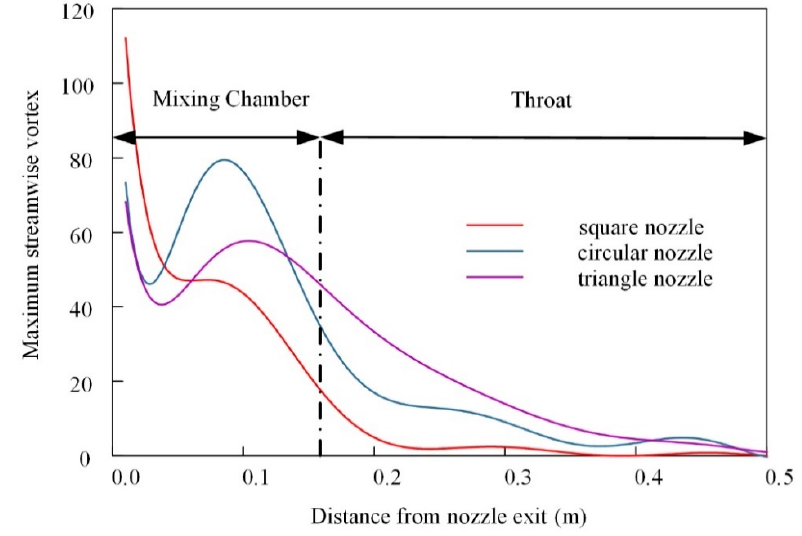
Figure 8. Decay of the maximum streamwise vortex.